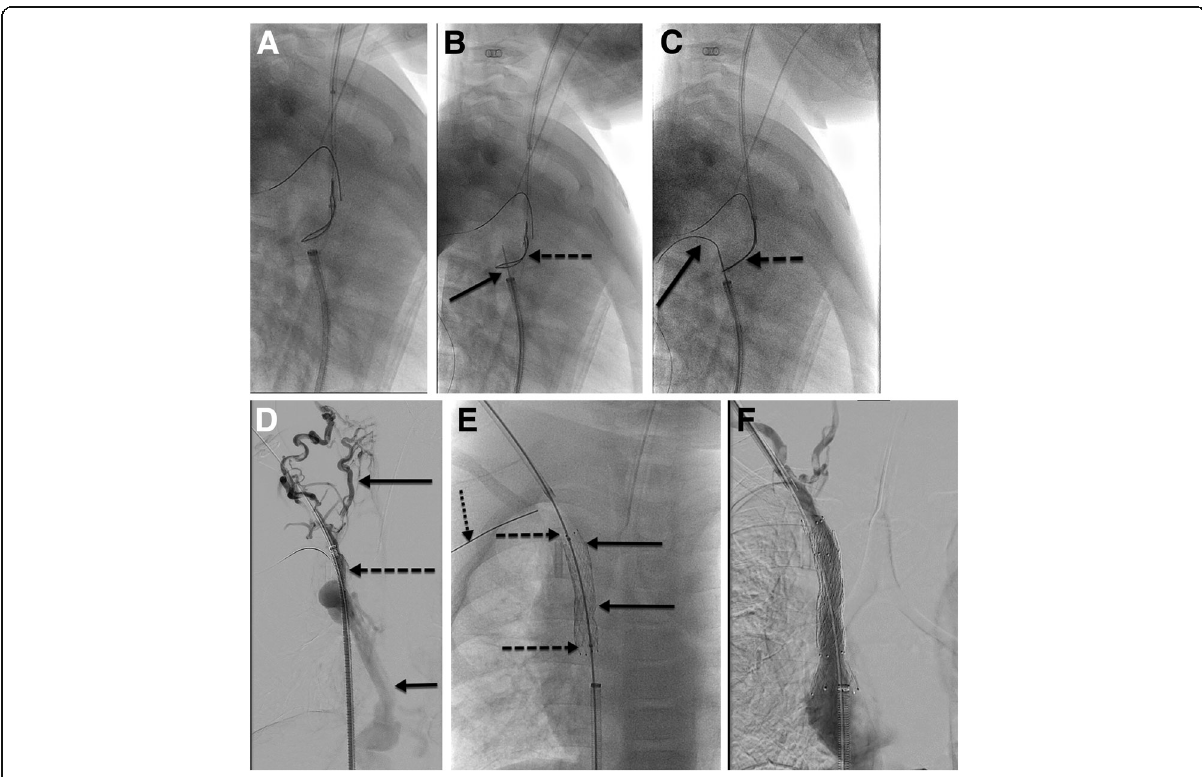
Fig. 7 4 y/o M with end stage renal disease requiring hemodialysis access and complete occlusion of the bilateral internal jugular veins and bilateral brachiocephalic veins. Hemodialysis access was from the right groin but he developed thrombus in that vessel and there was concern he would lose his ability for transplant consideration; thus access from the neck was desired. a Wire and sheath access from the right groin into the patent portion of the SVC. Snare and sheath access from a collateral vessel in the neck. Wire is also noted on the left periphery of the image marking the subclavian vein into the azygous vein. b A 22G 65 cm Chiba needle (solid arrow) was passed from the right groin sheath into the snare (dashed arrow) from the right neck venous access. c Inner obturator of needle was removed and replaced with a 0.018 ″ hydrophilic wire. Wire (solid arrow) was advanced centrally and snare tightened on wire (dashed arrow) while needle was retracted. d Sheath was advanced through the occlusion (dashed arrow) and venogram performed. Demonstrated numerous collateral venous vessels (upper solid arrow) with patent azygous vein (lower solid arrow) but no opacification of the occluded SVC. e Stent complex: balloon mounted Palmaz stent (Cordis Baar, Switzerland) deployed at the level of the complete occlusion (two solid arrows marking the cranial and caudal extent of the stent) and a self- expanding, Zilver 14 mm stent (Cook Bloomington, IN) deployed within the Palmaz stent. The stent complex connected the patent vessel